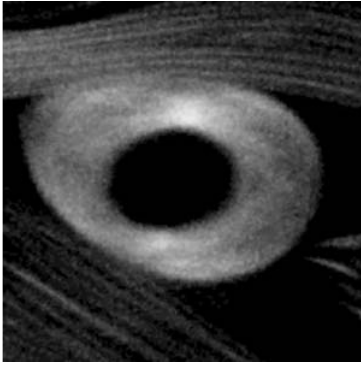
Video 2. Spindle Assembly in Control Spermatocytes Video 4. Spindle Assembly in Colcemid-Treated